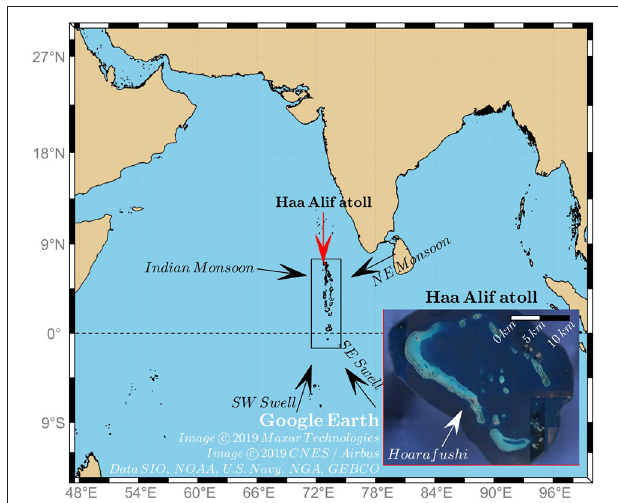
FIGURE 1 | Map of the Indian Ocean with the Maldivian archipelago inside the black box. The four black arrows indicate the main wave direction identified. The red arrow indicates the location of the Haa Alif atoll in which is located Hoarafushi island (satellite image in the bottom-right corner extracted from Google Earth. Image © 2019 Maxar Technologies; Image © 2019 CNES/Airbus; Data SIO, NOAA, U.S. Navy, NGA,